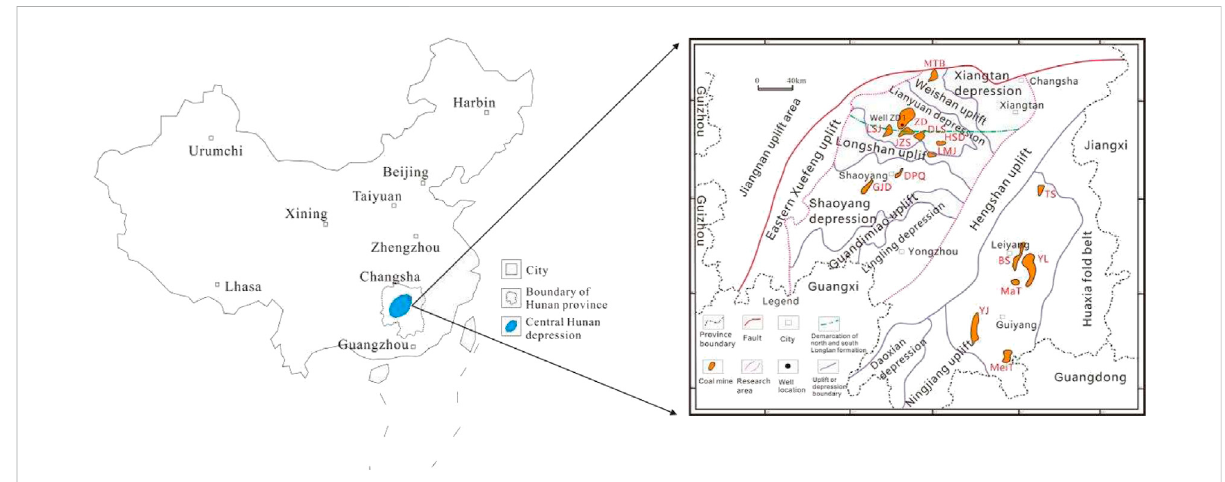
FIGURE 1 Structure outline map of central Hunan depression and distribution of mining